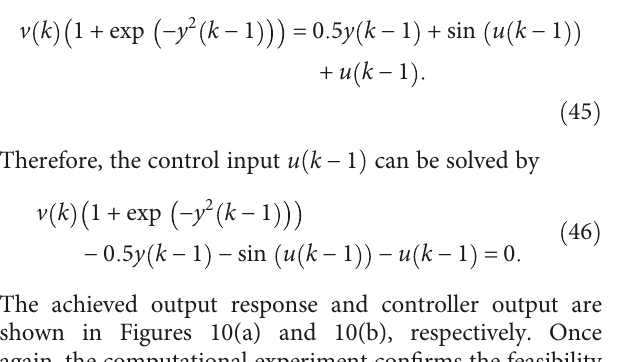
Figure 9: U-Model parameter